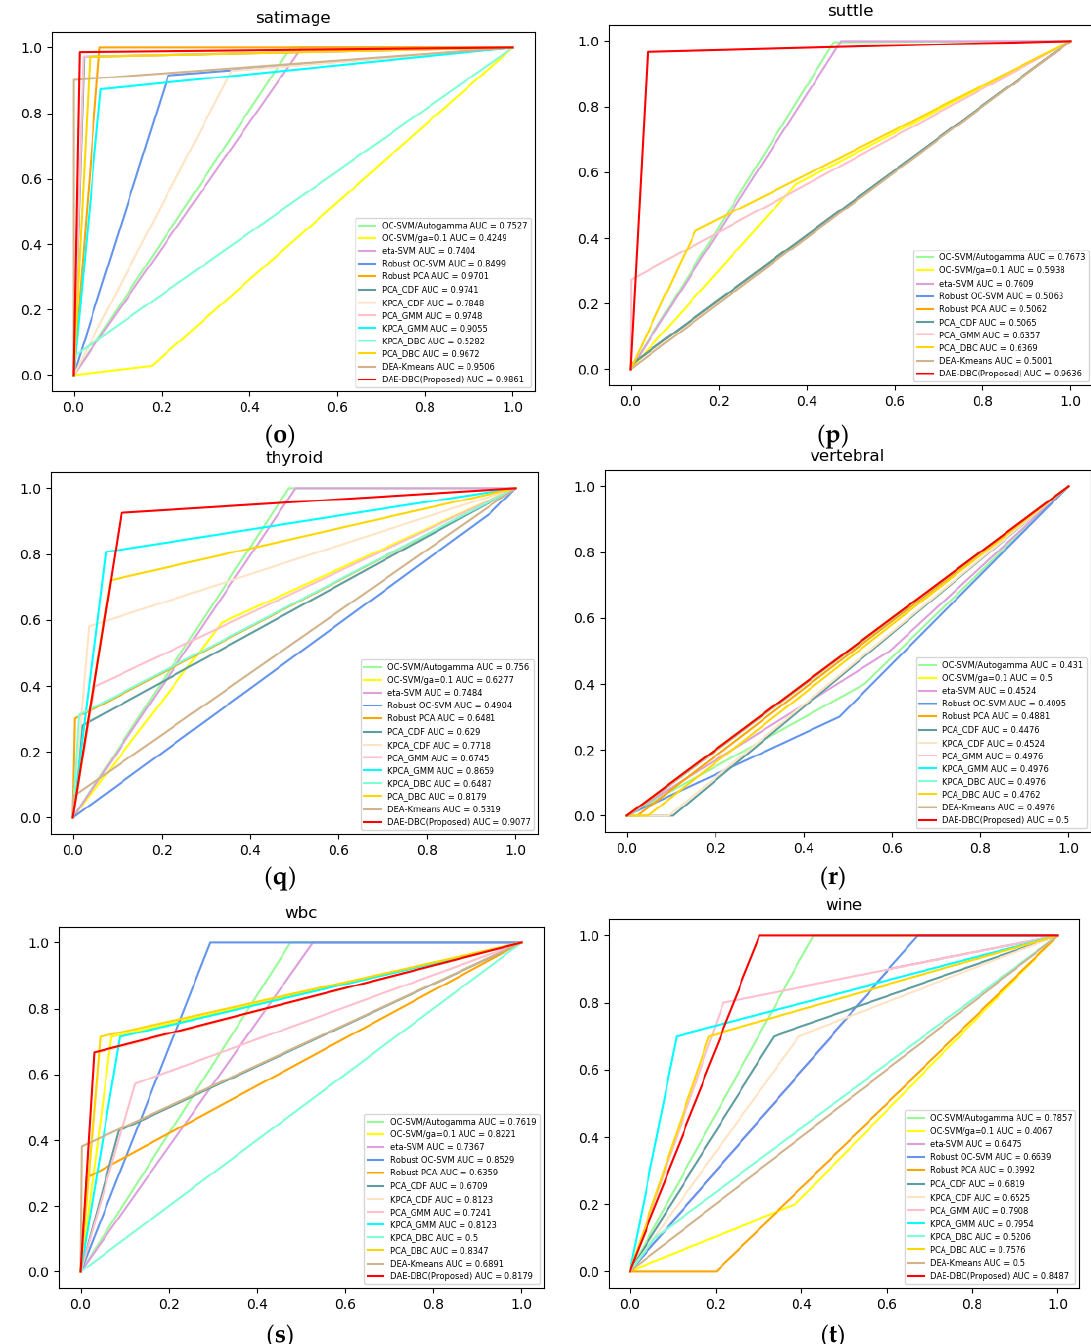
Figure 3. ROC curves of compared methods. ( a ) Annthyroid, 6 dimension, novelty ratio 0.08; ( b ) BreastW, 9 dimension, novelty ratio 0.53; ( c ) Arrhythmia, 274 dimension, novelty ratio 0.17; ( d ) Cardio, 21 dimension, novelty ratio 0.1; ( e ) Glass, 9 dimension, novelty ratio 0.04; ( f ) Ionosphere, 33 dimension, novelty ratio 0.56; ( g ) Letter, 32 dimension, novelty ratio 0.06; ( h ) Lympho, 18 dimension, novelty ratio; ( i ) Mnist, 100 dimension, novelty ratio 0.1; ( j ) Musk, 72 dimension, novelty ratio; ( k ) Optdigits, 64 dimension, novelty ratio 0.03; ( l ) Pendigits, 16 dimension, novelty ratio 0.02; ( m ) Pima, 8 dimension, novelty ratio 0.5; ( n ) Satellite, 36 dimension, novelty ratio 0.46; ( o ) Satimage, 36 dimension, novelty ratio 0.01; ( p ) Suttle, 9 dimension, novelty ratio 0.07; ( q ) Thyroid, 6 dimension, novelty ratio 0.02; ( r )Vertebral, 6 dimension, novelty ratio 0.14; ( s ) Wbc, 30 dimension, novelty ratio 0.05; ( t ) Wine, 13 dimension, novelty ratio 0.08.